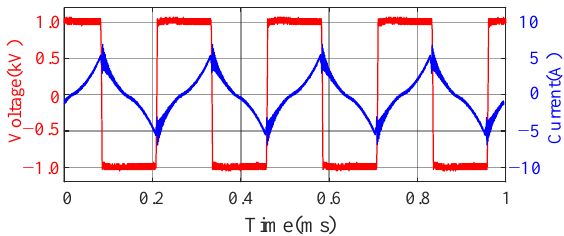
Figure 24. Experimental platform and the MFT prototype.